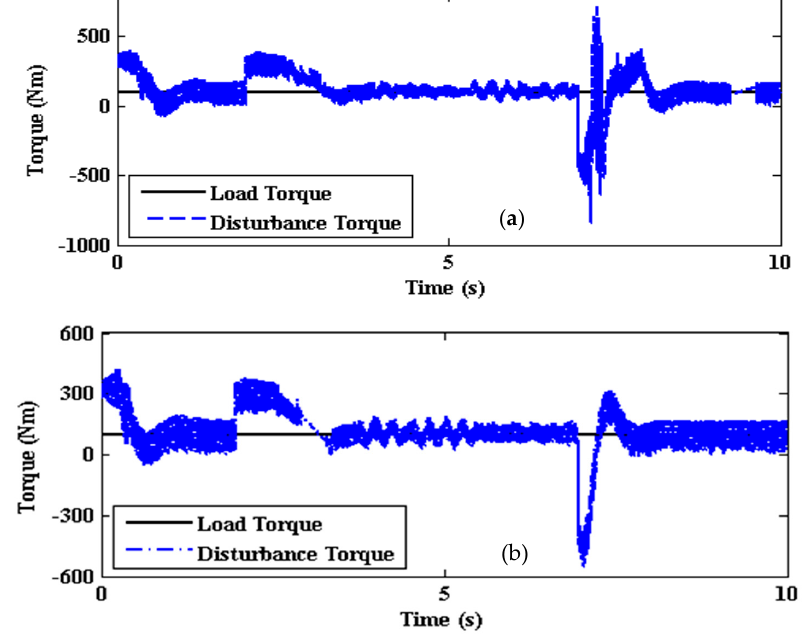
Figure 16. Estimated disturbance torque of ( a ) SMLO 1; and ( b ) SMLO 2.